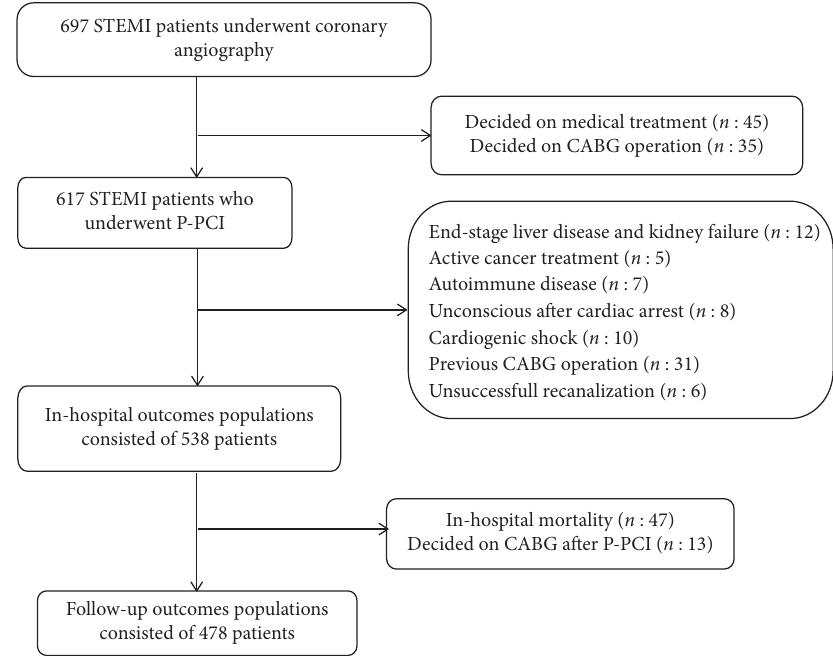
Figure 1: Flow diagram demonstrating enrollment and follow-up study